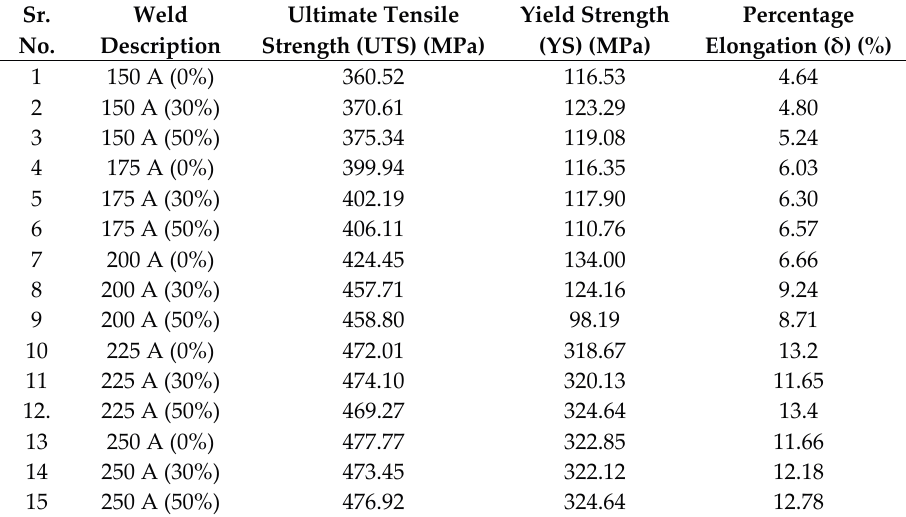
Figure 16. Stress vs. displacement at Ia of 225 A. The inset shows the fractured surfaces of the tested samples. Table 3. Tensile tests results of welded